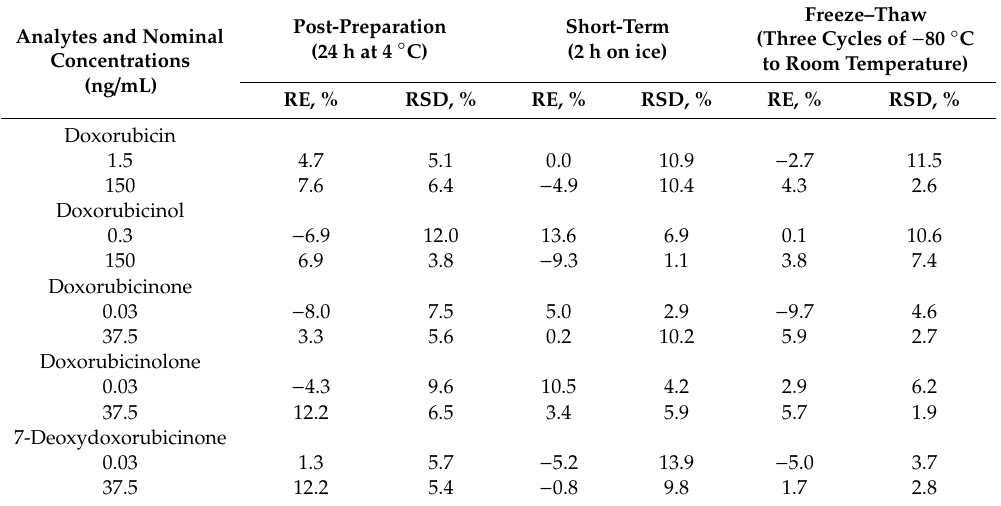
Table 3. Post-preparation, short-term, and freeze–thaw stabilities of doxorubicin, doxorubicinol, doxorubicinone, doxorubicinolone, and 7-deoxydoxorubicinone in mouse plasma QC samples (n = 3). Post-Preparation Analytes and Nominal (24 h at 4 ◦ Concentrations (ng / mL)